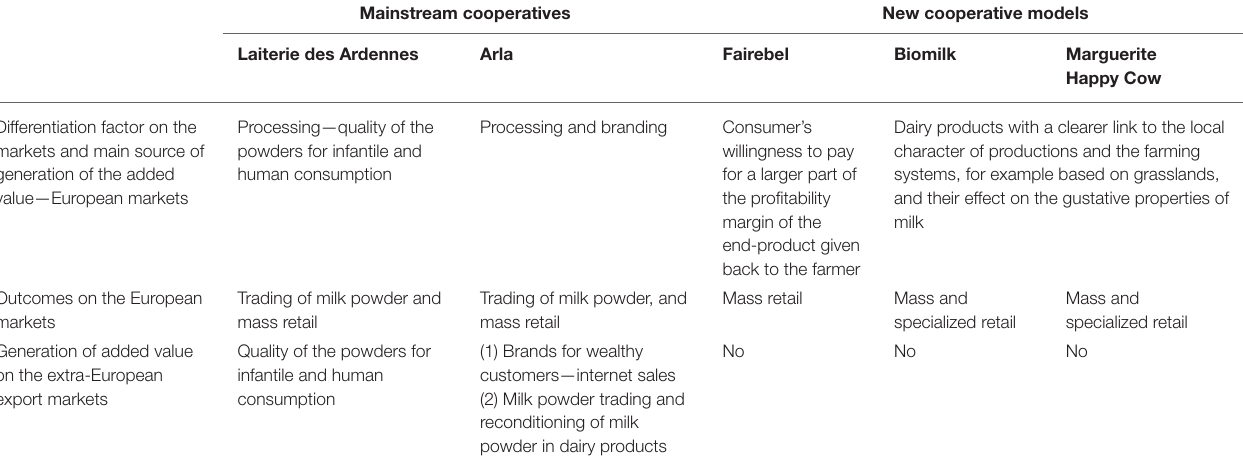
TABLE 2 | Generation of added value on the markets and differentiation factors of the studied